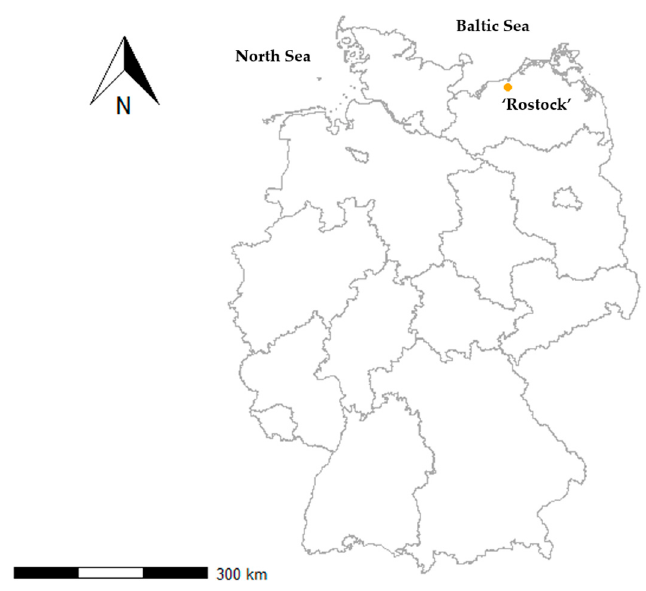
Figure 1. Location of “Rostock” in northeast Germany.